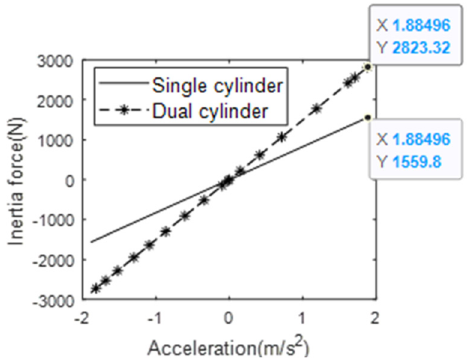
Figure 9. The comparison curve of inertia force and acceleration.